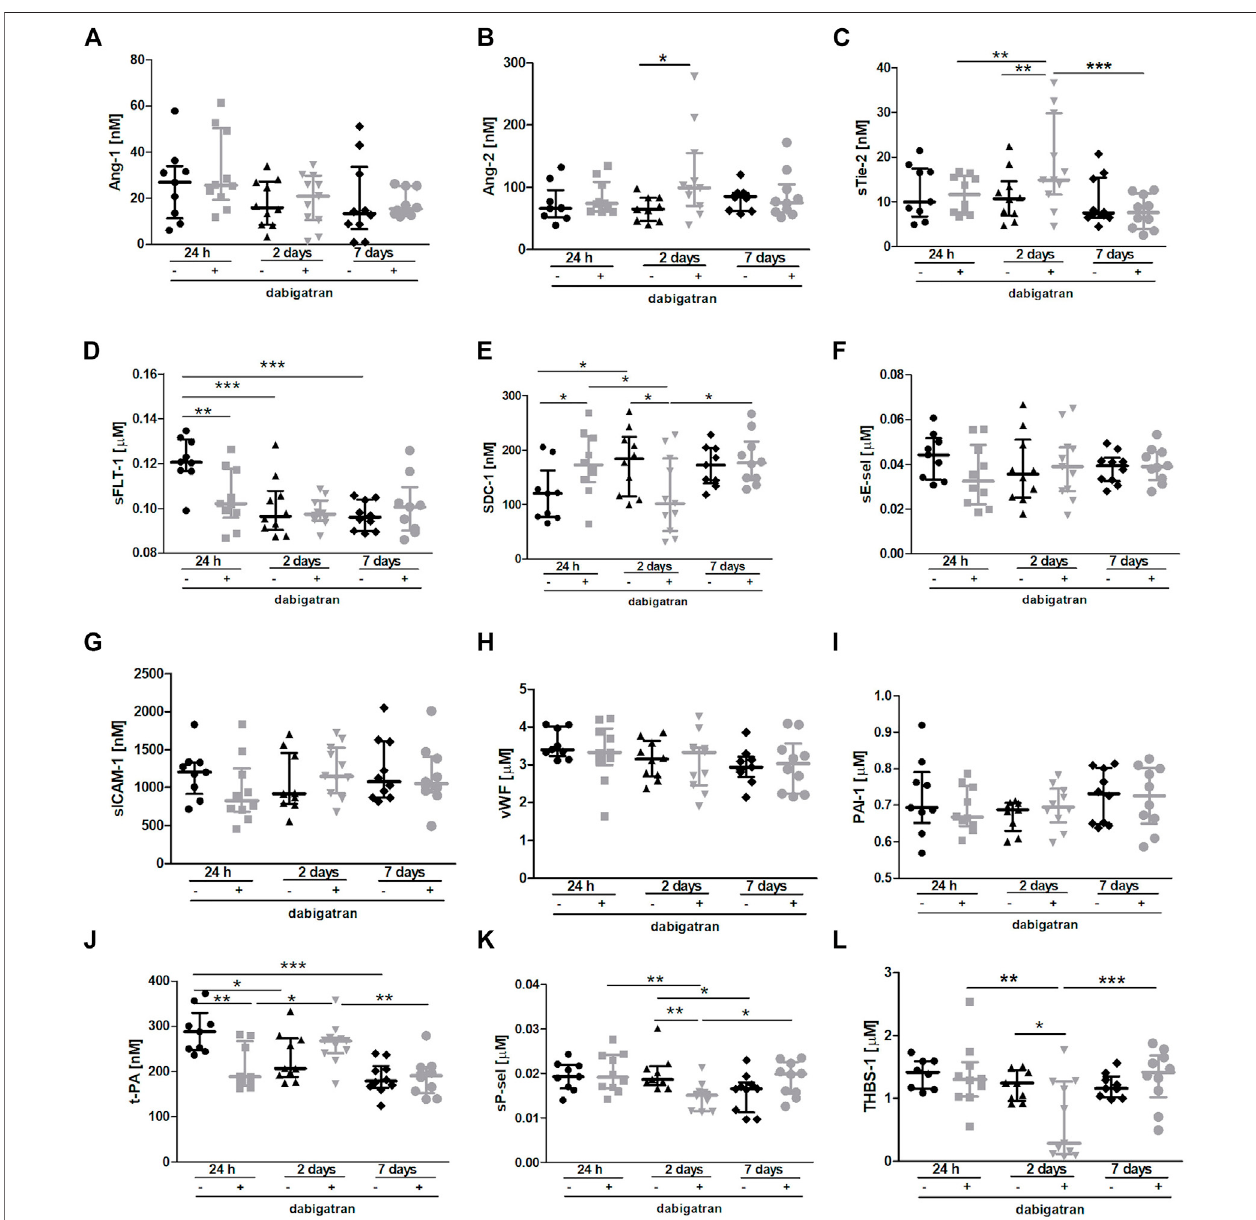
FIGURE4| EffectsofdabigatranonendotheliumfunctionbasedonselectedbiomarkersofendothelialdysfunctioninBALB/cmiceinjectedwith4T1breastcancer cells. Mice were treated with vehicle (black symbols) or dabigatran etexilate (grey symbols) as described in Section 2.5 , injected with 4T1 breast cancer cells, and euthanized at 24 h, 2 days, and 7 days after 4T1 breast cancer cell injection. The panel of selected biomarkers of endothelial dysfunction (Ang-1 (A) , Ang-2 (B) , sTie-2 (C) , sFLT-1 (D) , SDC-1 (E) , sE-sel (F) , sICAM-1 (G) , vWF (H) , PAI-1 (I) , t-PA (J) , sP-sel (K) , and THBS-1 (L) ) was measured in the plasma using the microLC/MS- MRMmethodasdescribedin Section2 .Thedataarepresentedasthemedian±IQR.Statisticalanalysiswasperformedwithtwo-wayANOVA (A,C – H,J – L) orKruskal- Wallis (B,I) tests followed by appropriate post hoc tests. The symbols *, **, and *** denote statistical signi fi cance at p < .05, p < .01, and p < .001, respectively.